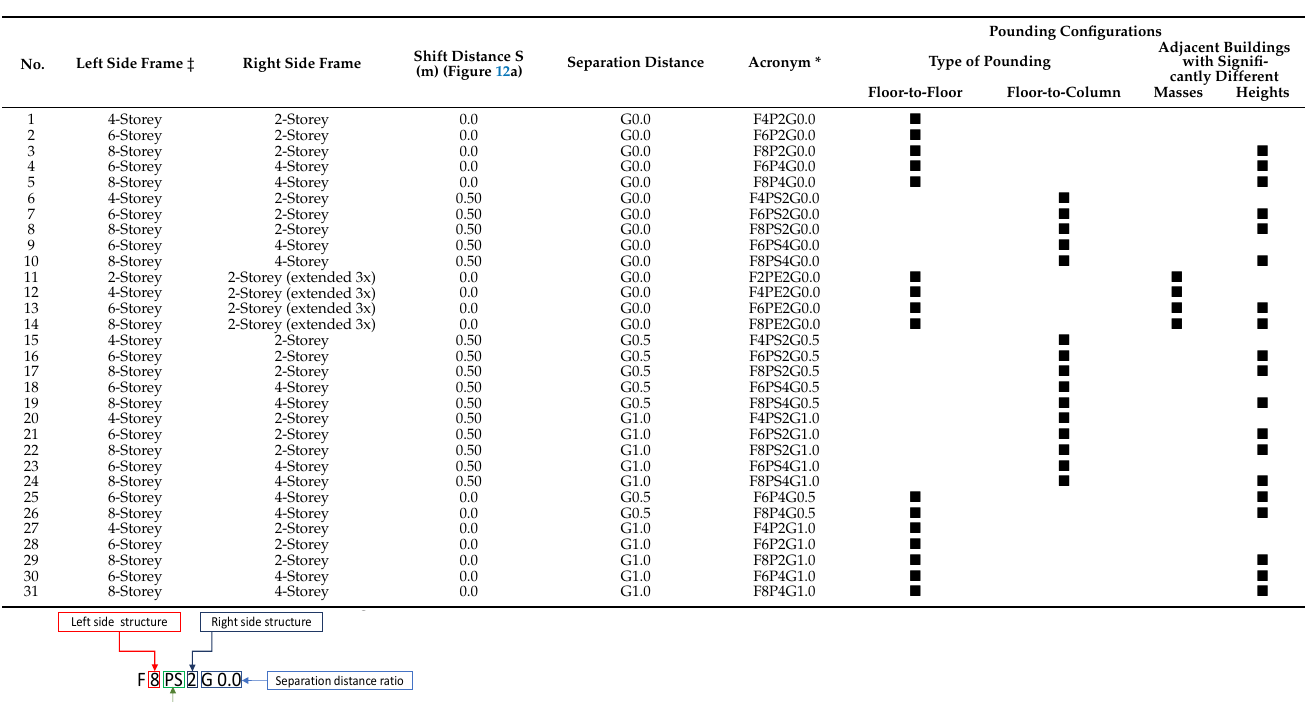
Table 2. Characteristics of the considered adjacent structures representing the different critical pounding configurations ( (cid:4) marks the selected characteristics of a given pounding configuration).